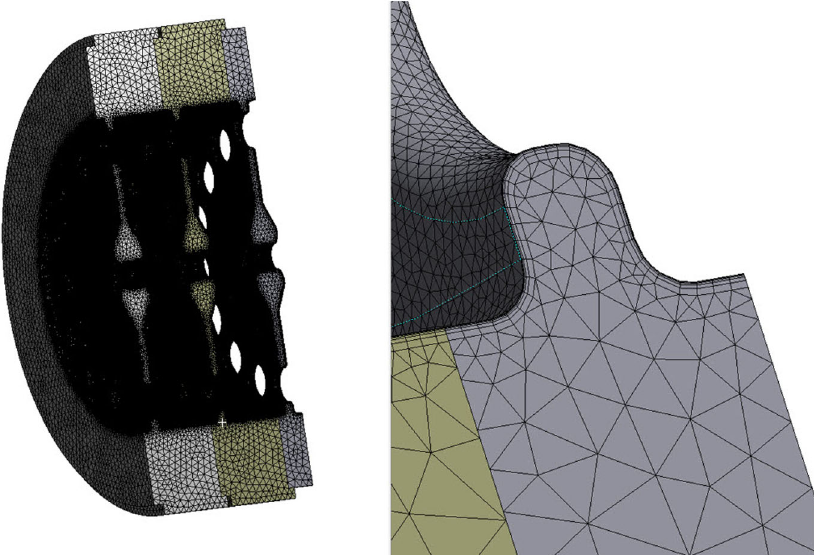
FIG. 19. ANSYS mesh for transient thermal analysis model.